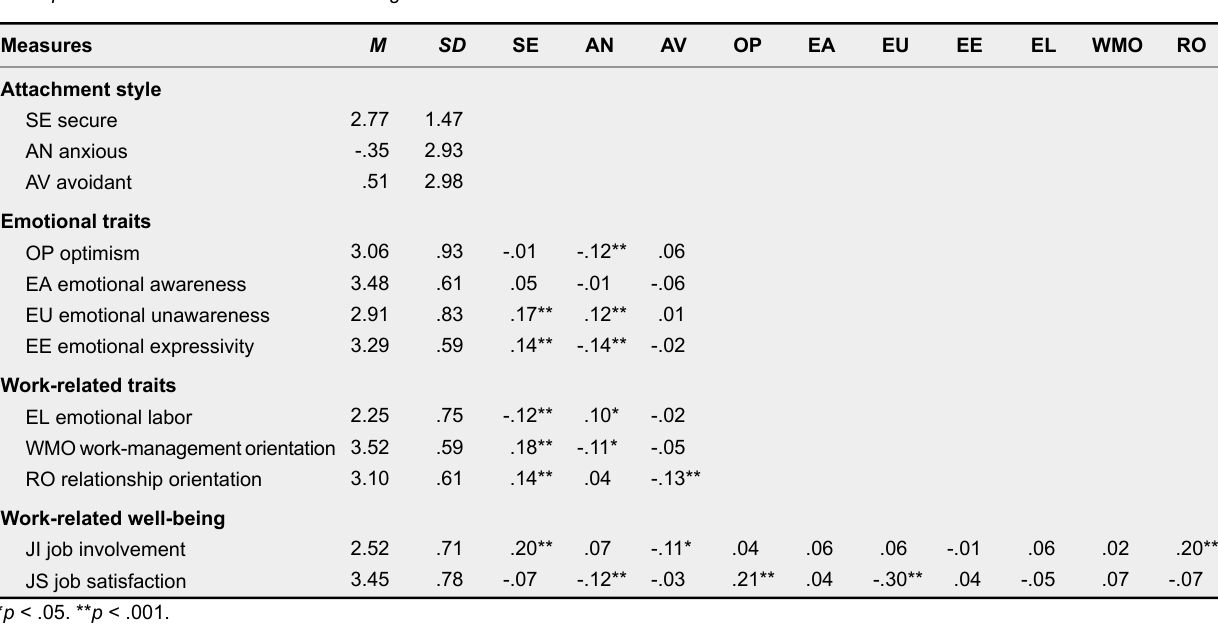
Descriptive Statistics and Correlations Among